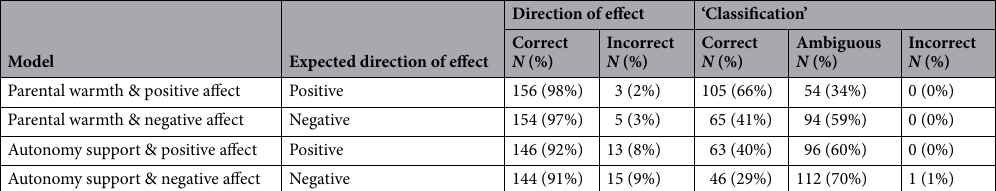
Table 3. Direction of point estimates and ‘classification’ of family-specific estimates in the models with child- reported parenting (H2). For 20% of the families, each of the four family-specific parenting-affect associations was correctly classified.